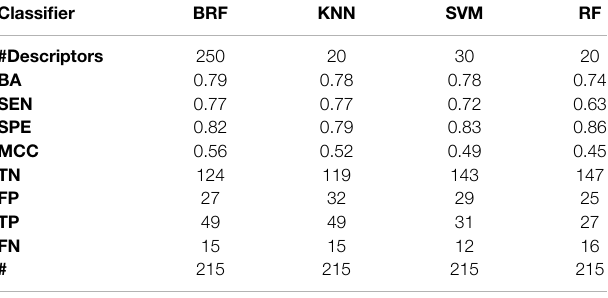
TABLE 4 | Performance of the best models developed on the HSE + LSE + NSE/ INA partitioning scheme on the TeS. For each model, the following statistics are reported: Balanced Accuracy (BA), Sensitivity (SEN), Speci fi city (SPE), Matthews Correlation Coef fi cient (MCC), number of True Negatives (TN), False Positives (FP), True Positives (TP) and False Negatives (FNs).